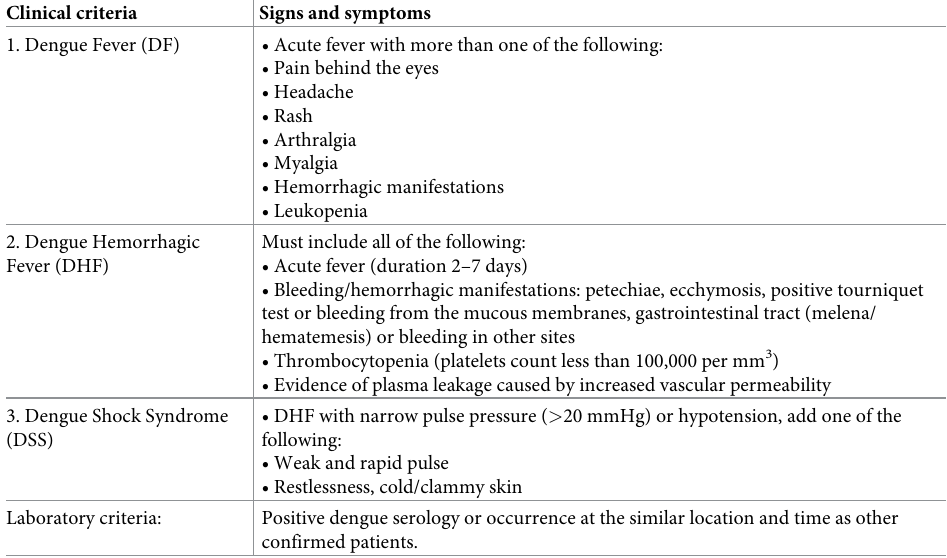
Table 1. Definition for dengue diseases; adapted from reference [9].